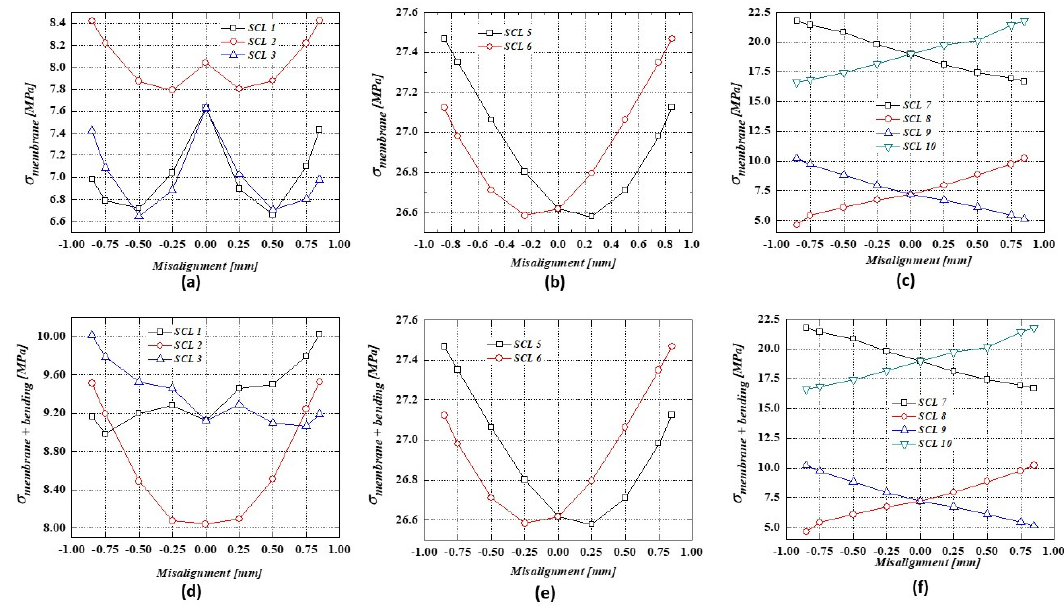
Figure 7. Primary membrane stress for various misalignment conditions: ( a ) sodium to sodium channel; ( b ) steam to steam channel; ( c ) between steam and sodium channels; And combined membrane and bending stress: ( d ) between sodium channel; ( e ) between steam channel; ( f ) between steam and sodium channels.